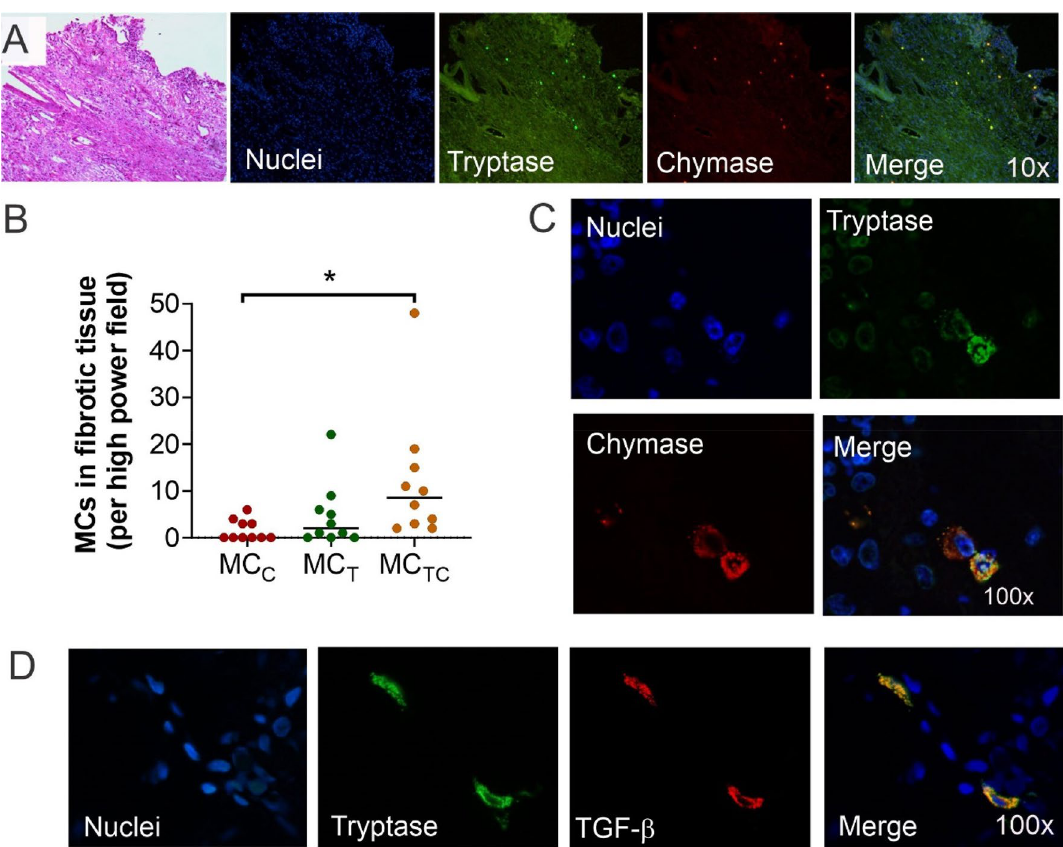
Figure 4. Tryptase and chymase positive mast cells are numerous in fibrotic lesions of tuberculous lungs. ( A ) Representative low power micrograph of fibrotic tuberculous nodule stained with HE and immunofluorescence micrographs from the same lesion shows MC T (green), MC C (red) and MC TC (merge). ( B ) MCs subtypes counted in ten different high-power fields (microarrays) (40 ×) from 44 autopsy cases confirm that MC TC were the most abundant phenotype at fibrotic areas. ( C ) High power micrograph at fibrotic areas shows MCs that express tryptase and chymase cytoplasmic granules which are partially degranulated. Shapiro–Wilk test was done to determine normality. Representative section of a fibrotic area was incubated with anti-TGF-β (Alexa 647 label) and anti-tryptase antibodies (Alexa 488 label). ( D ) High power micrograph shows TGF-β